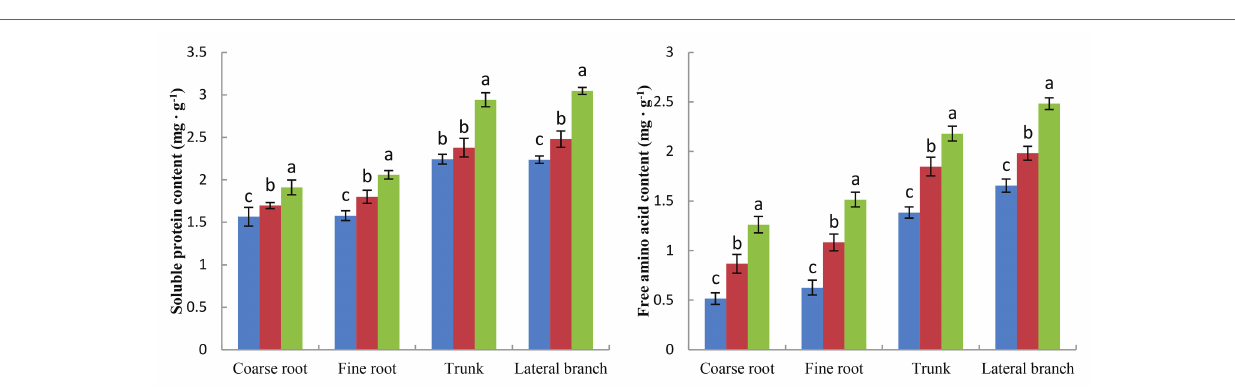
FIGURE 8 | Effects of BCRF on soluble protein content and free amino acid content in different organs. The vertical bars indicate the standard deviation of three replications. Different letters indicate statistically significant differences ( p <